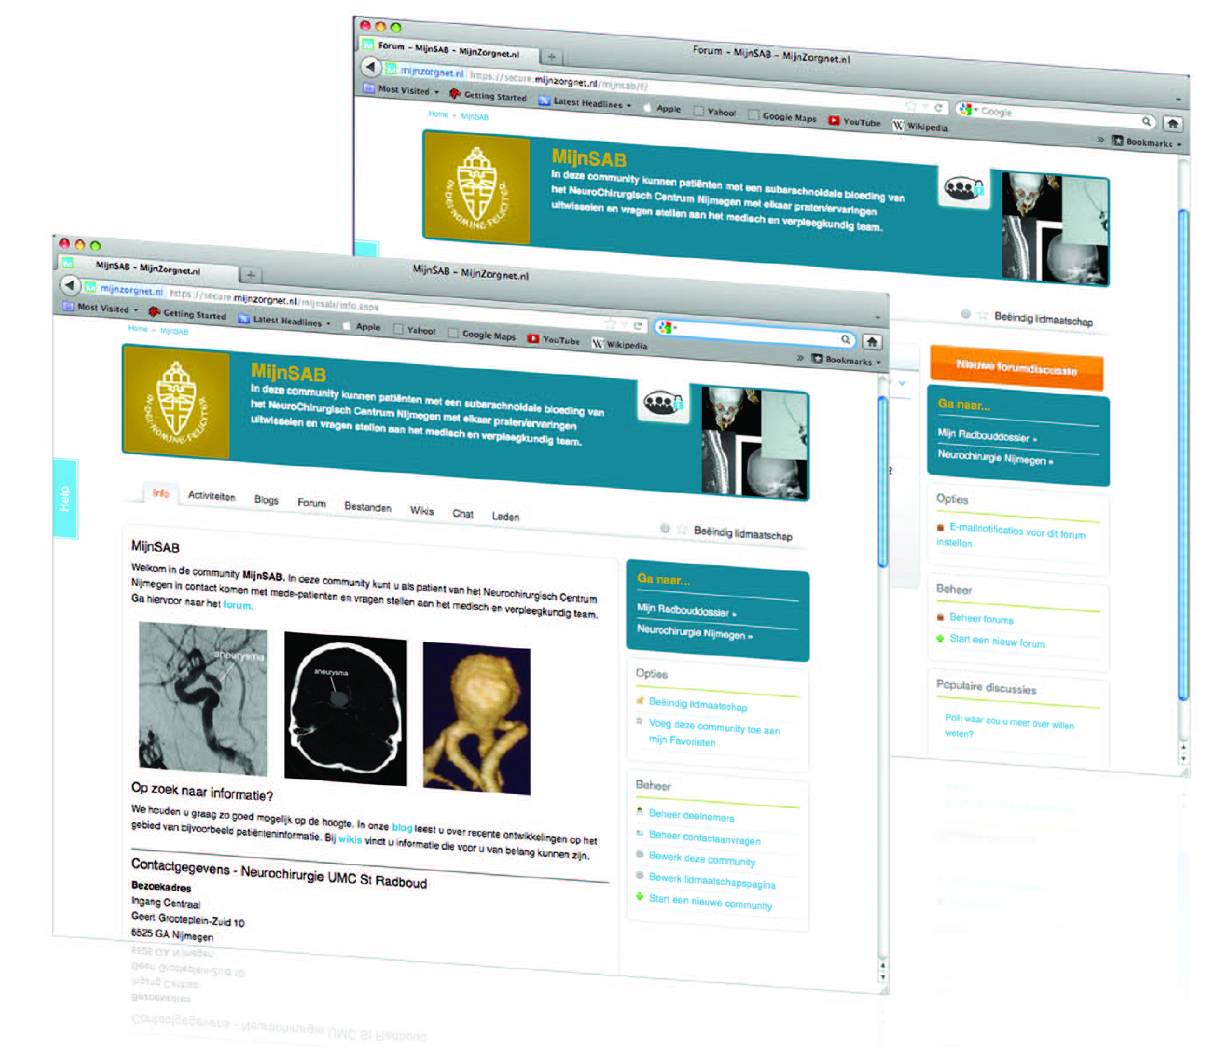
Figure 1. Poster of access